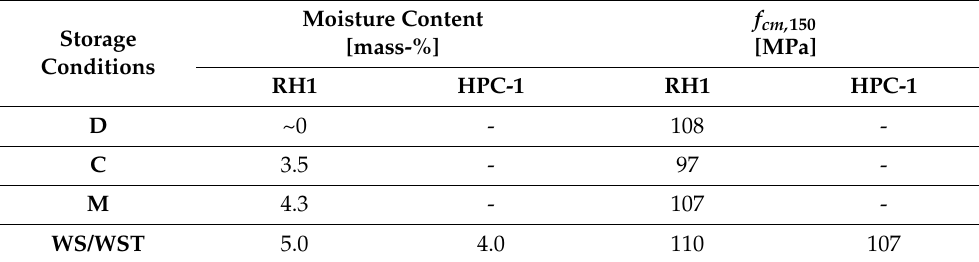
Table A1. Material properties of RH1 and HPC-1 [22].